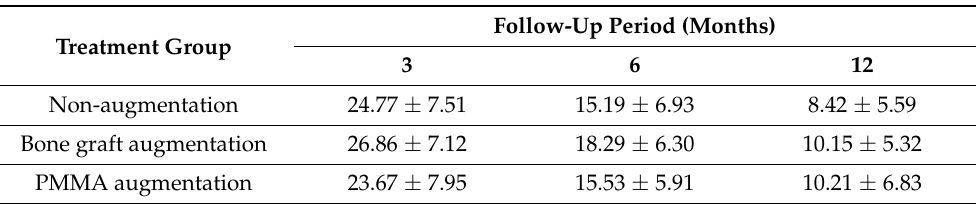
Table 3. DASH score in the treatment groups at three different follow-up periods, presented in terms of mean value and standard deviation.